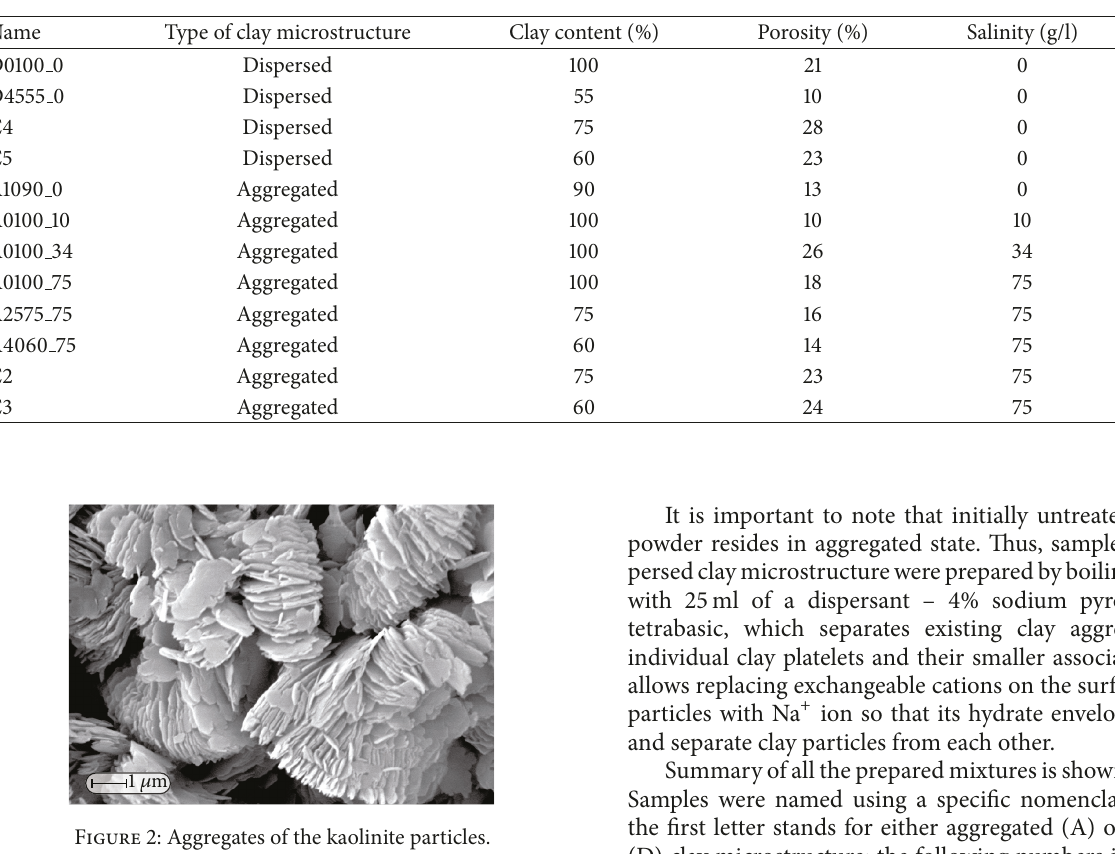
Table 1: Specification of the samples.